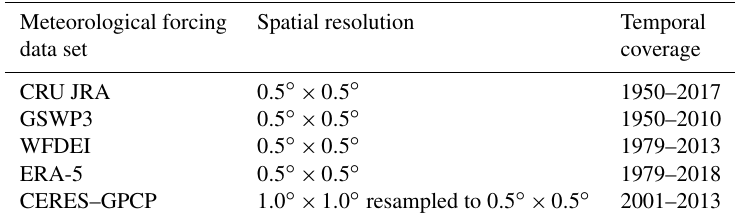
Table 1. Global meteorological forcing data sets used in FLUXCOM-RS +